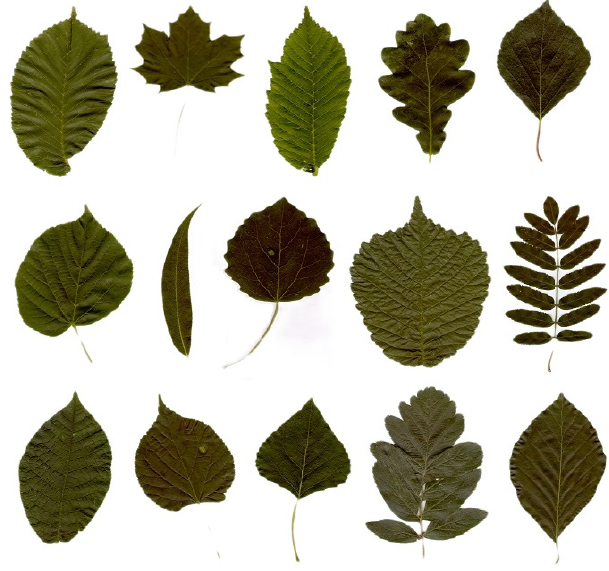
Figure 18. Sample images of the Flavia leaf dataset, one image per species. Table 6. Comparison with other methods on the Flavia leaf dataset.